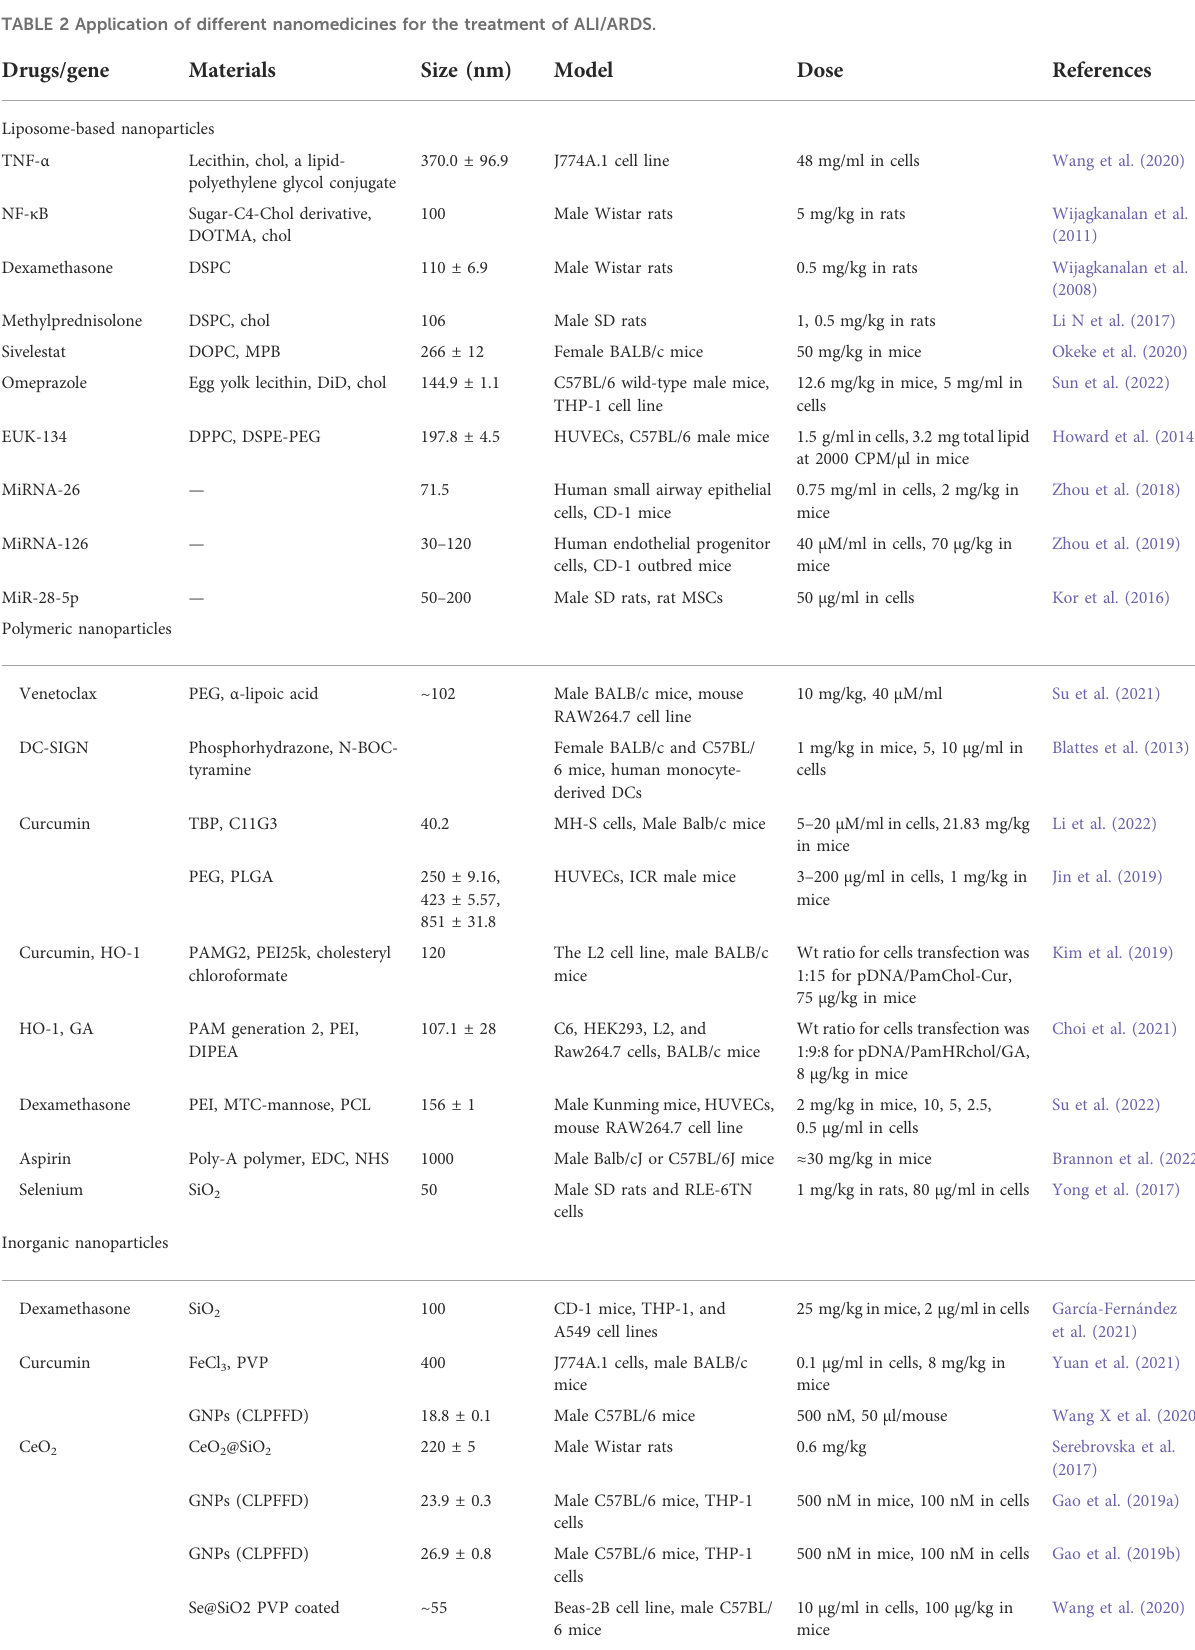
TABLE 2 Application of different nanomedicines for the treatment of